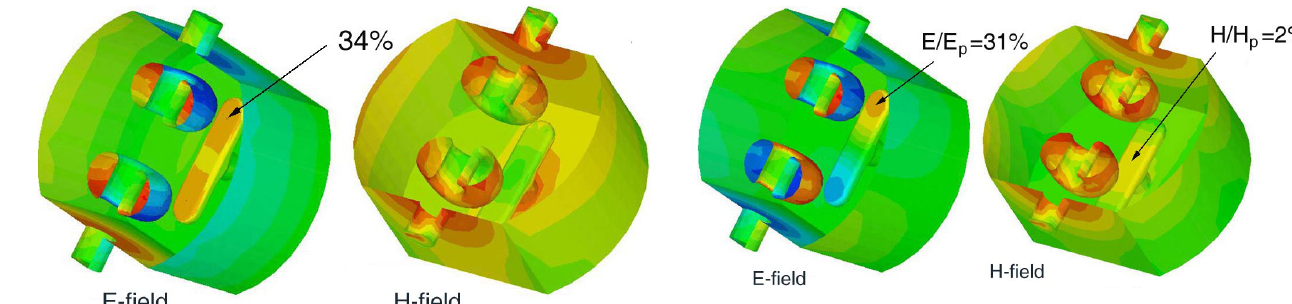
FIG. 4. (Color) Distribution of E -field and H -field at a rotary tuner (RT) in 2-QWR, mode 1 oriented along the beam axis. In the left picture, the number as a percentage is the ratio E=E blue is negative charge and red positive charge. In the right picture, red corresponds to high H -field, green to low field.